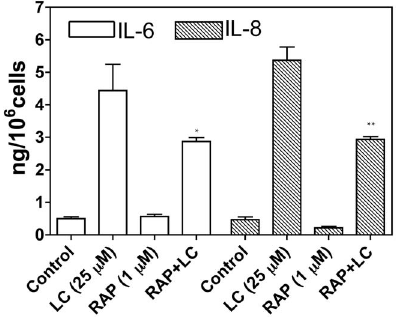
Figure 3. Effect RAP on myeloma light chain (LC)- stimulated cytokine production. Cells were pre-incubated for 1-h with or without 1 m M RAP and then exposed to 25 m M myeloma LC for a further 4-h. Interleukins 6 and 8 were then assayed in the cell supernatants. LC-stimulated the production of both IL-6 and IL-8, and both were significantly inhibited by the presence of RAP, 1 m M, in cell culture medium (p , 0.05). Bars represent the mean 6 SE for each group (n=3, *p , 0.05 vs LC, **p , 0.01 vs LC, one-way